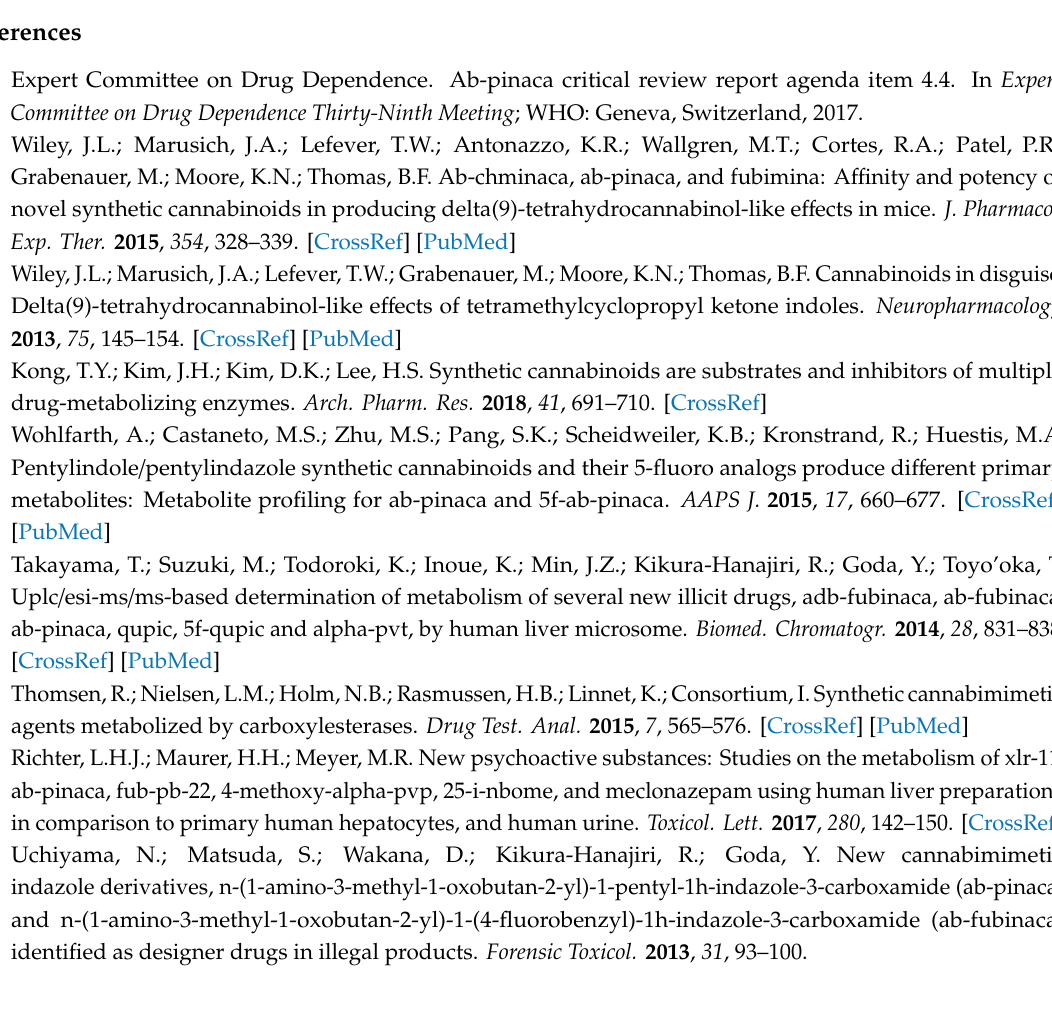
Figure S1. SRM chromatograms of CYP metabolites formed from human liver microsomal incubation of eight CYP cocktail substrates with NADPH and two internal standards (IS), Figure S2. SRM chromatograms of six UGT metabolites formed from human liver microsomal incubation of six UGT cocktail substrates with UDPGA and two IS, Table S1. SRM parameters of eight CYP metabolites, six UGT metabolites, and their internal standards